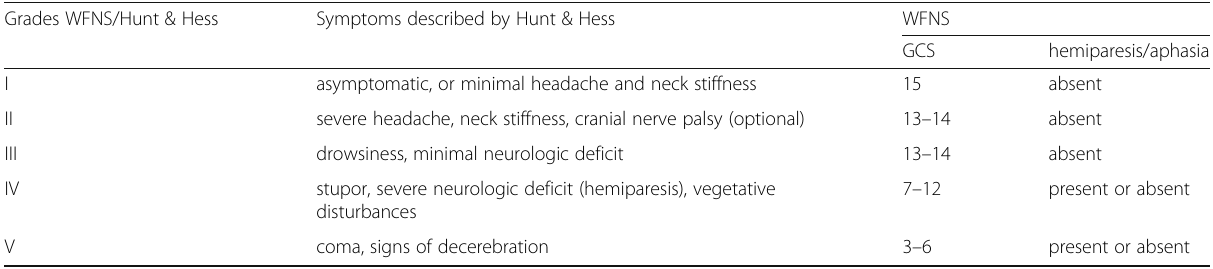
Table 1 Clinical Grading as defined by the World Federation of Neurological Surgeons (WFNS), Hunt & Hess and in relation to the Glasgow Coma Scale (GCS)